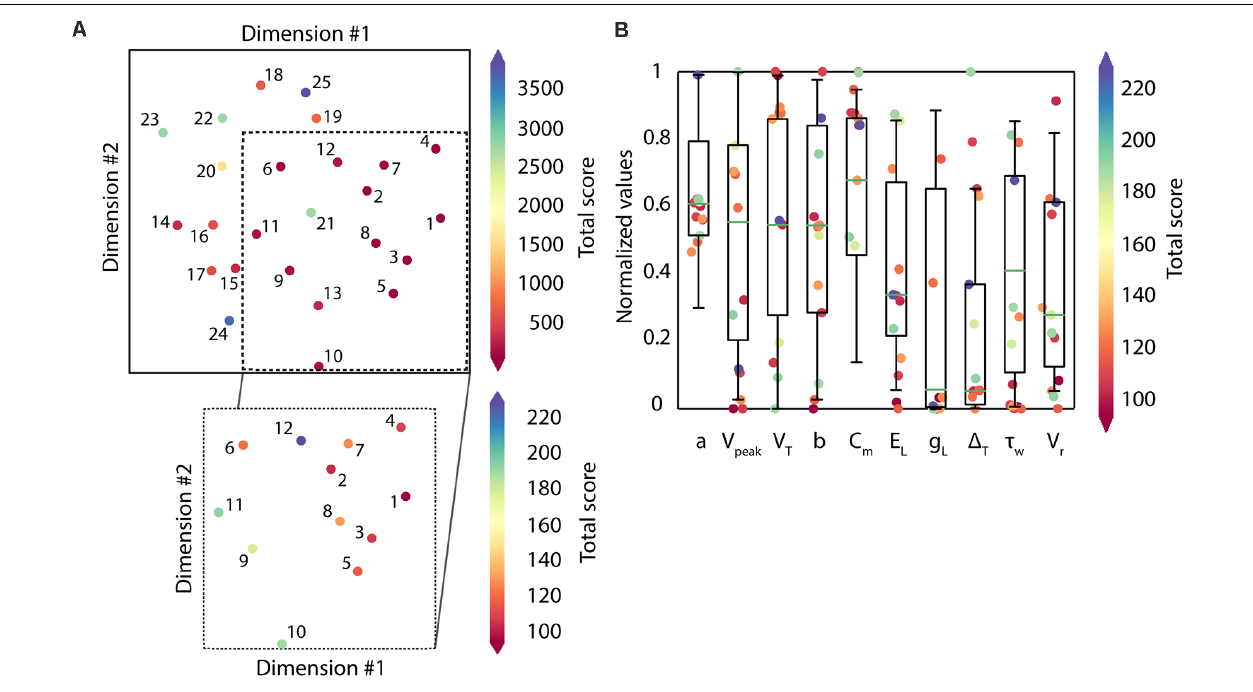
FIGURE 5 | Distribution of the candidate solutions and their respective parameter values. (A) Representation of the population of solutions ( n = 25) using Classical Multidimensional Scaling (MDS). The colormap shows the total score of each candidate solution, red-colored being the solutions with the lowest scores (best solutions). In zoom, the most representative candidates (those with scores under 250 units; n = 12). (B) Parameter distribution of the candidate solutions. Each dot corresponds to the parameter value that defines every candidate solution with the lowest scores (those with scores under 250 units; n = 12). The colormap reflects the total score obtained by each parameter. The boxes correspond to the interquartile ranges (IQR) between the first (Q1) and the third (Q3) quartiles. The green line represents the median among the values obtained for each parameter. The whiskers correspond to the 5- and 95- percentile respectively.